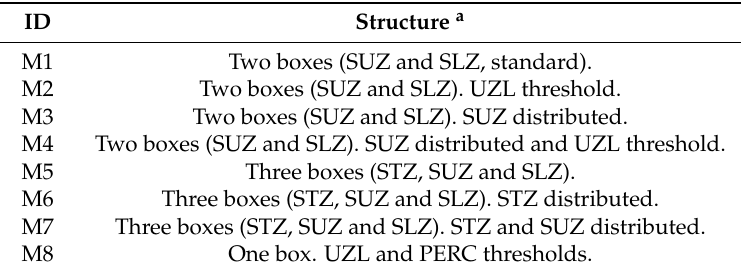
Table 2. HBV-light model